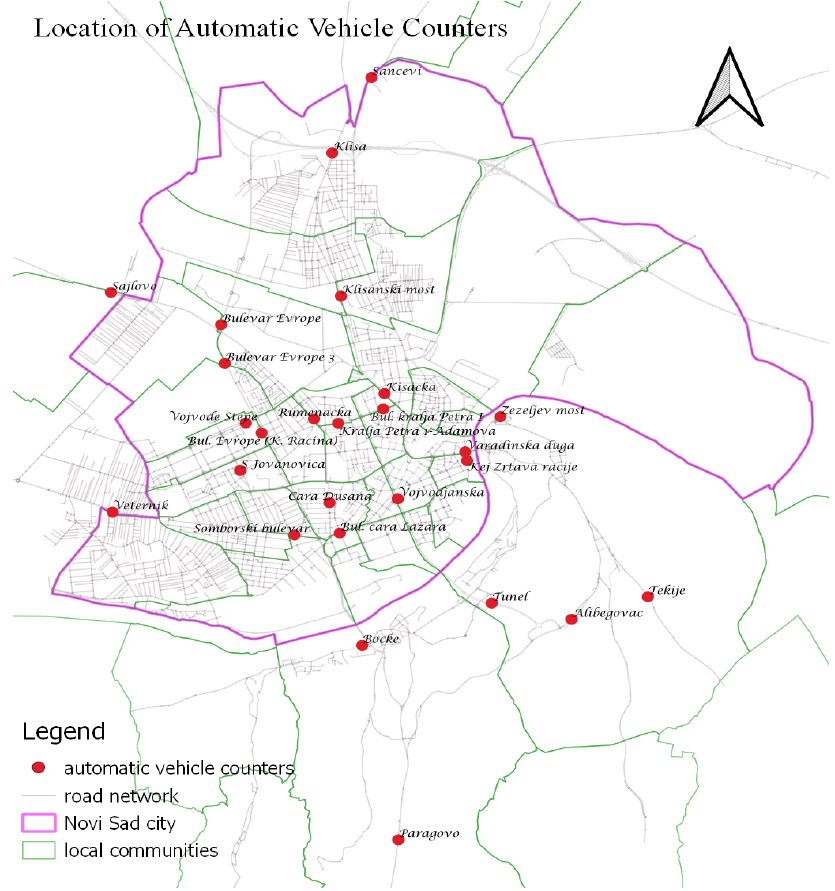
Figure 4. Location of automatic vehicle counters in the case study area.